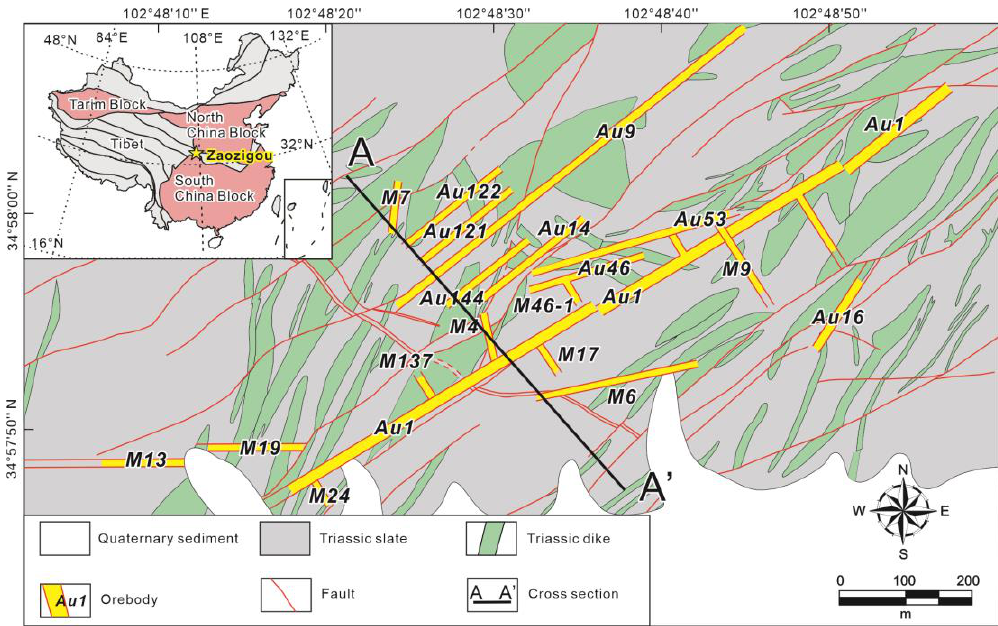
Figure 6. Geological sketch map of the Zaozigou Au – Sb deposit (modified after [66]).